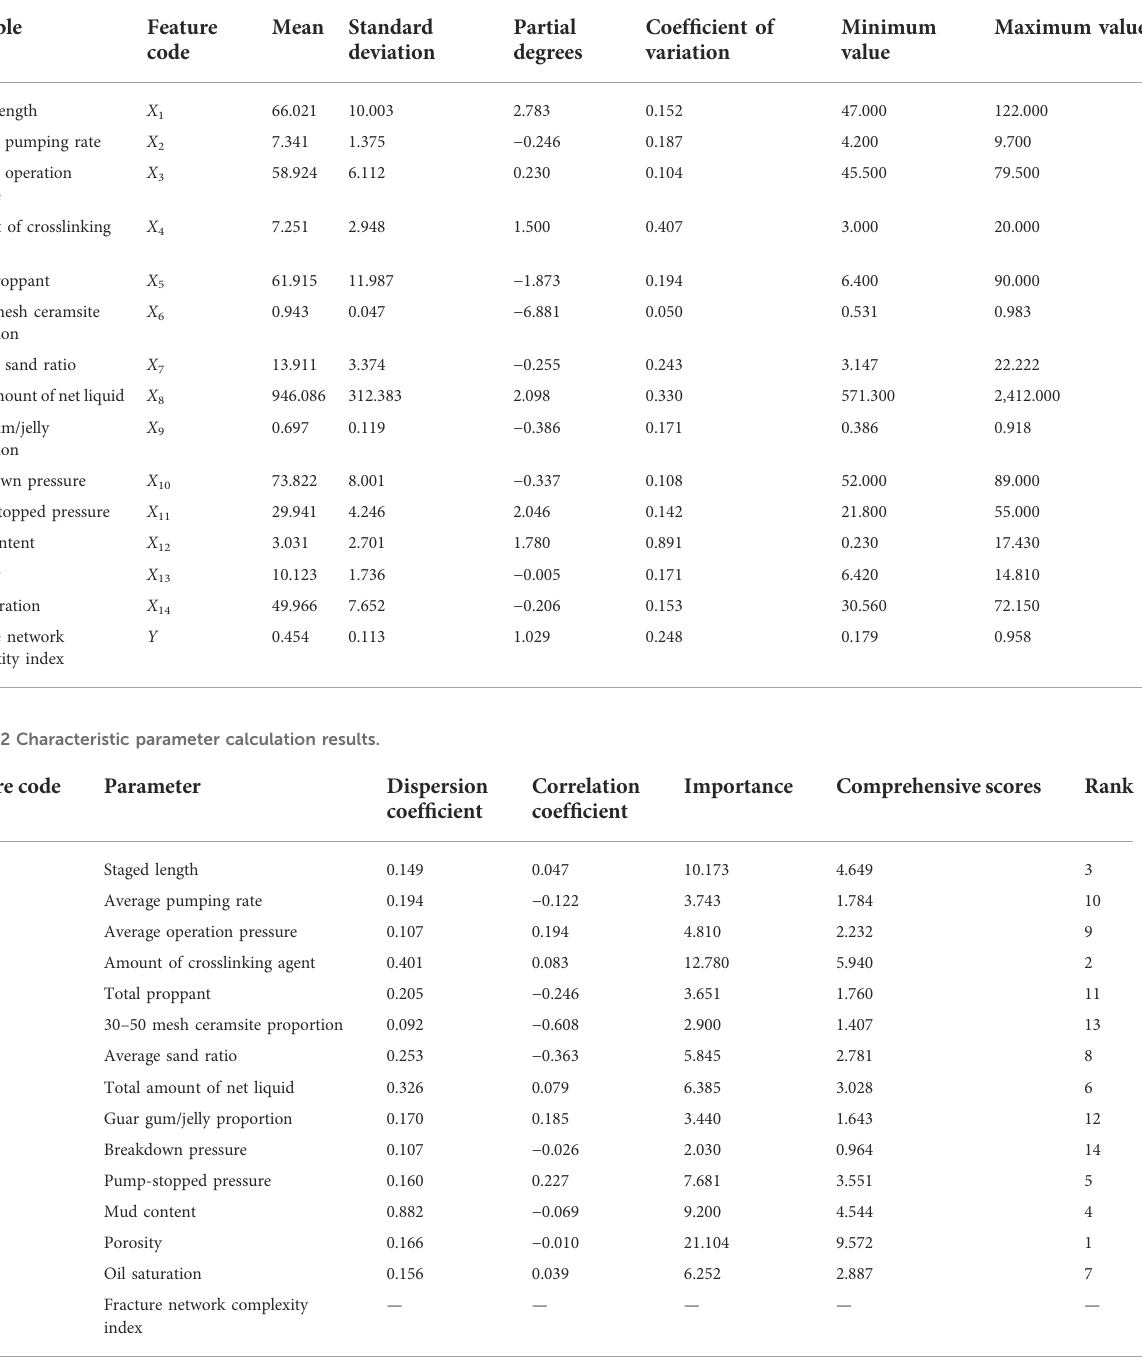
TABLE 1 Descriptive statistical table of characteristic parameters.